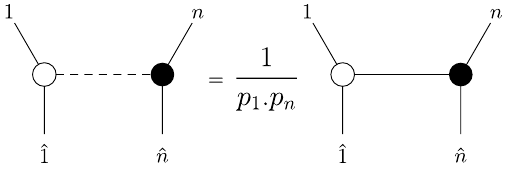
Figure 5 . Tree-level BCFW recursion relations in N = 8 SUGRA.